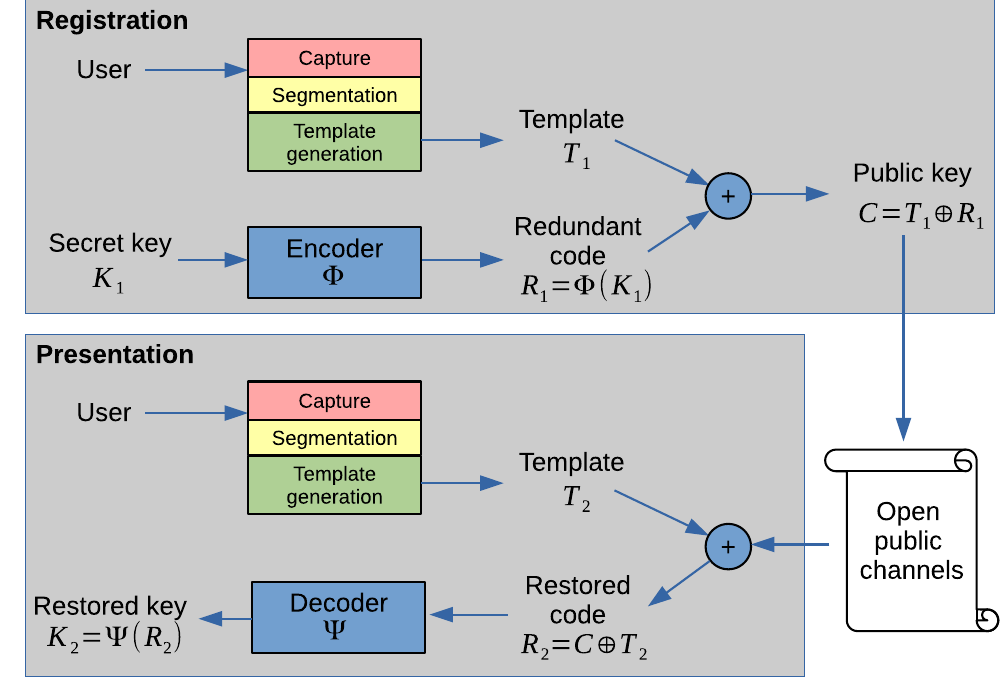
Figure 4. Scenario of the method